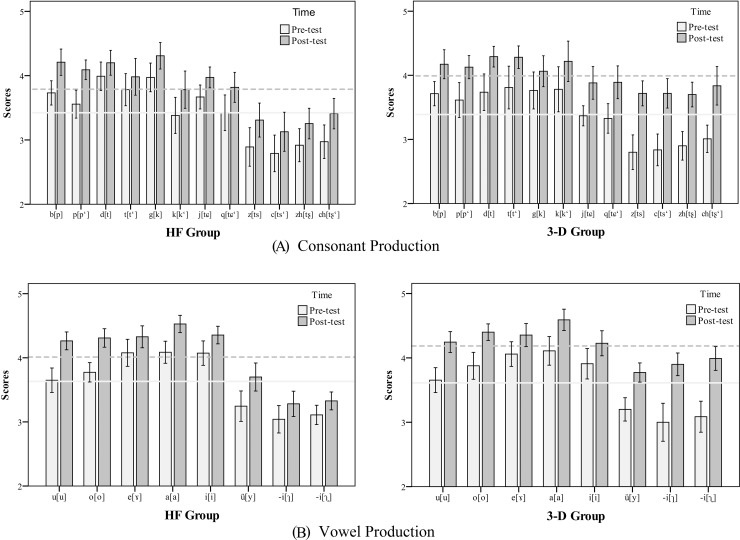
The Pre-test and Post-test Scores for Different Mandarin Consonants (A) and Vowels (B) in HF Group (left) and 3-D Group (right) in Experiment 2. The light solid lines indicate the average pre-test scores for different consonants or vowels, and the dark dashed lines refer to the average post-test scores (Error bars: +/- 1 SE).